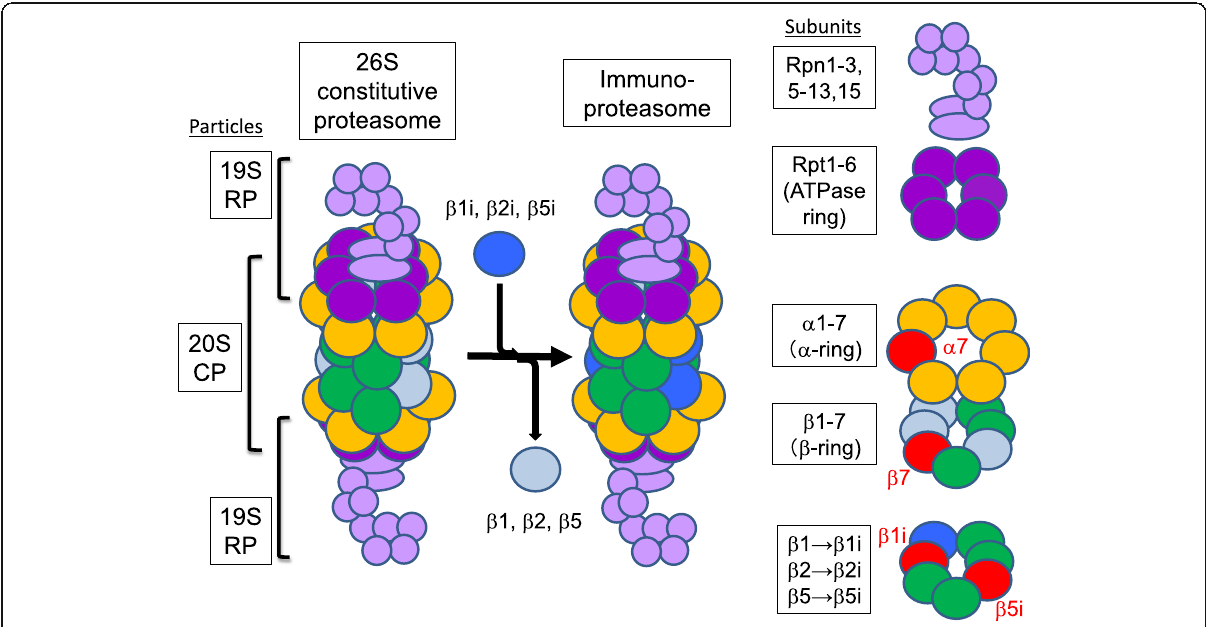
Fig. 2 Scheme of the proteasome complex. Subunits with mutations causing PRAASs were shown in